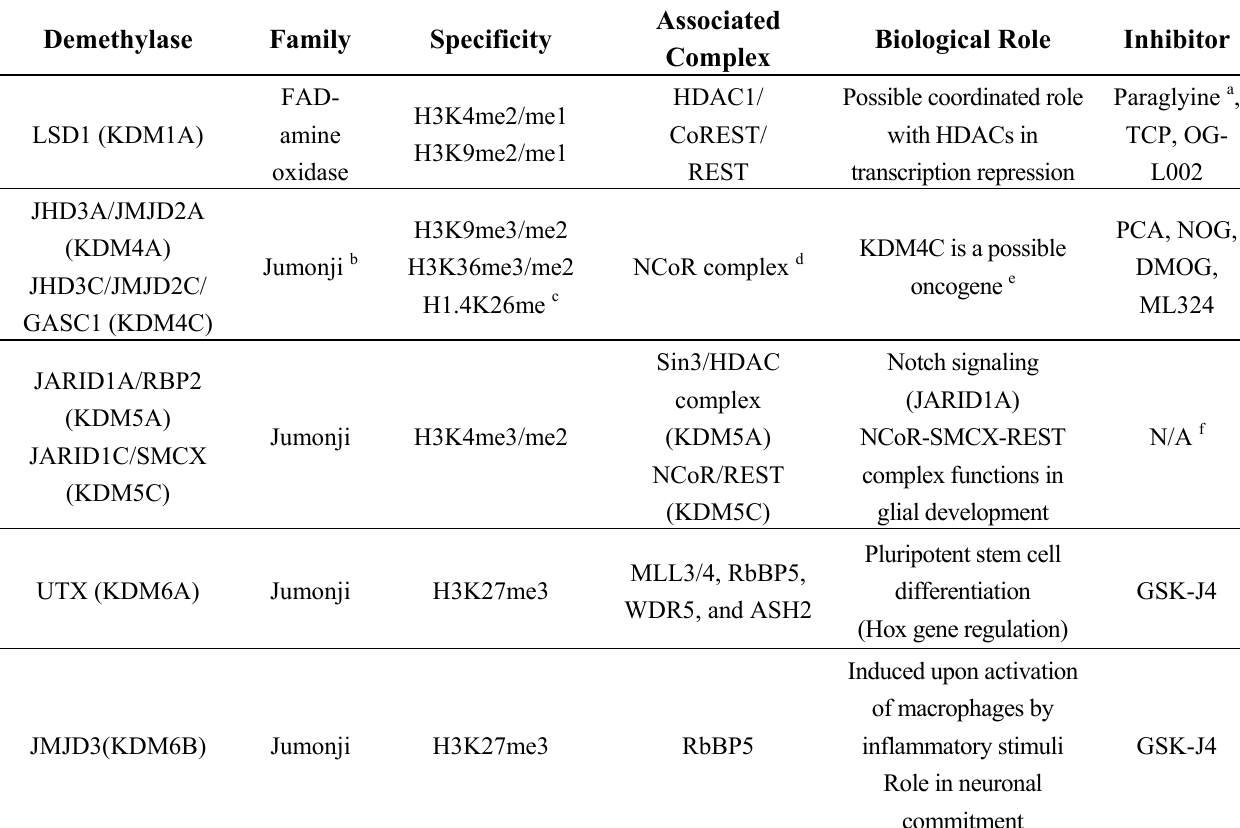
Table 1. The predicted role of histone demethylases in HSV-1 reactivation. Demethylase Family Specificity